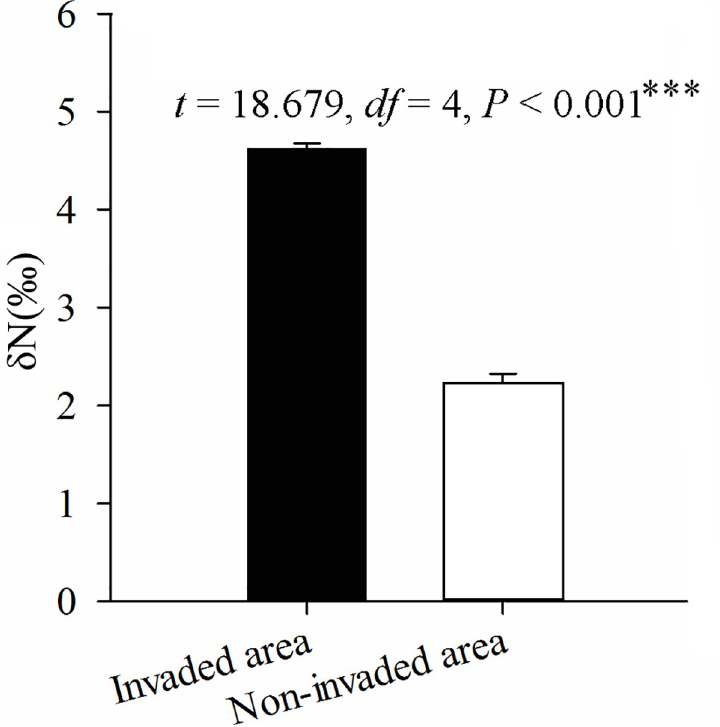
Fig 3. Stable isotope content ( δ N) (Independent sample t test, mean ± SE, 3 biological replicates were both collected from 3 separate invaded sites and 3 separate non-invaded sites) of T . melanocephalum workers from S . invicta invaded and non-invaded areas. Asterisks indicate significant differences ( ��� P <